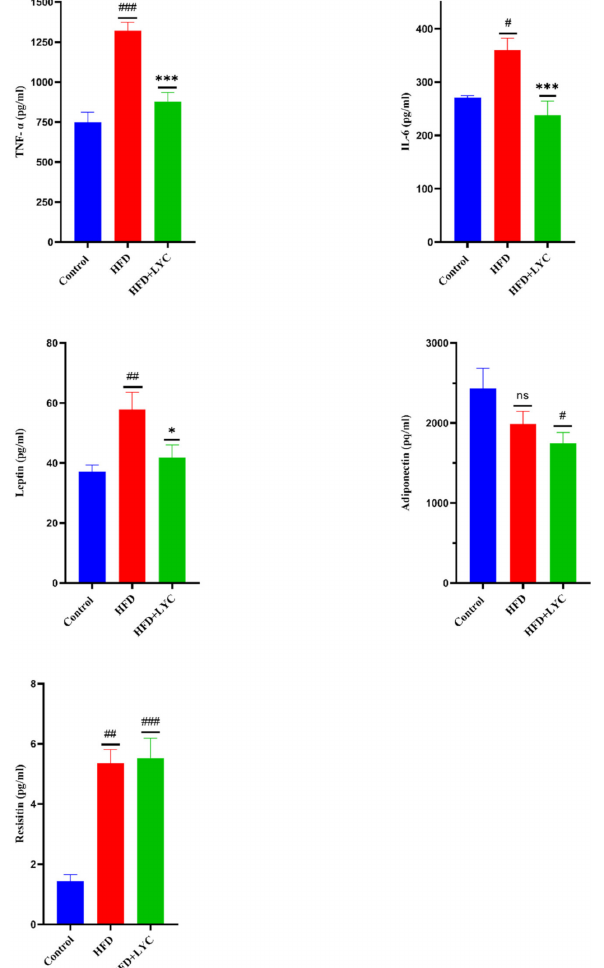
Figure 3. Hepatic levels of inflammatory markers TNF- α , IL-6, leptin, adiponectin, and resistin following treatment with LYC in rats fed an HFD. Data are expressed as the mean ± SEM of two replica ( n = 12 rats). Different markers correspond to statistically significant difference between groups. # p < 0.05, ## p < 0.01, and ### p < 0.001 indicate significant, highly significant, and very highly significant differences compared with the control, respectively. * p < 0.05 indicates a significant difference, while *** p < 0.001 indicates a very highly significant difference compared to the HFD group. ns: